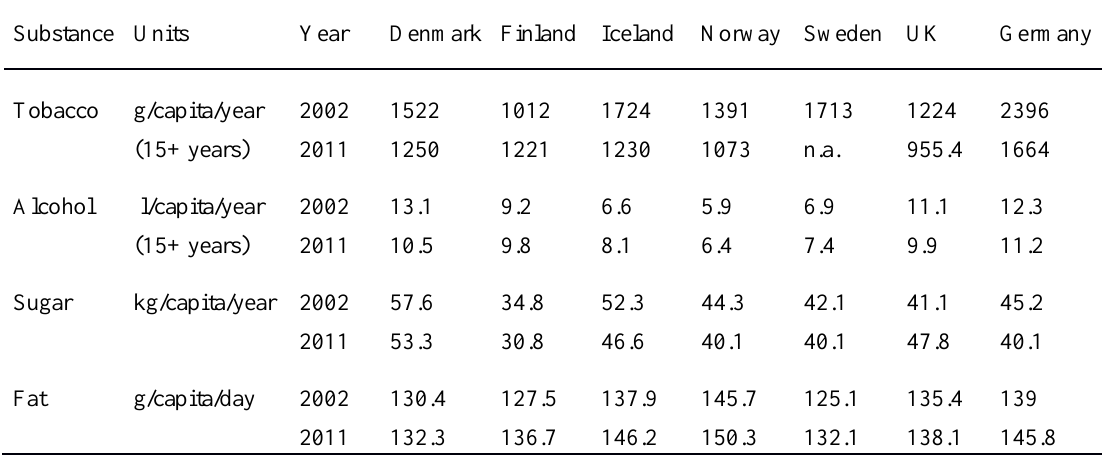
Table 4: Consumption of tobacco, alcohol, sugar and fat, Nordic countries, UK and Germany, 2002 and 2011 Substance Units